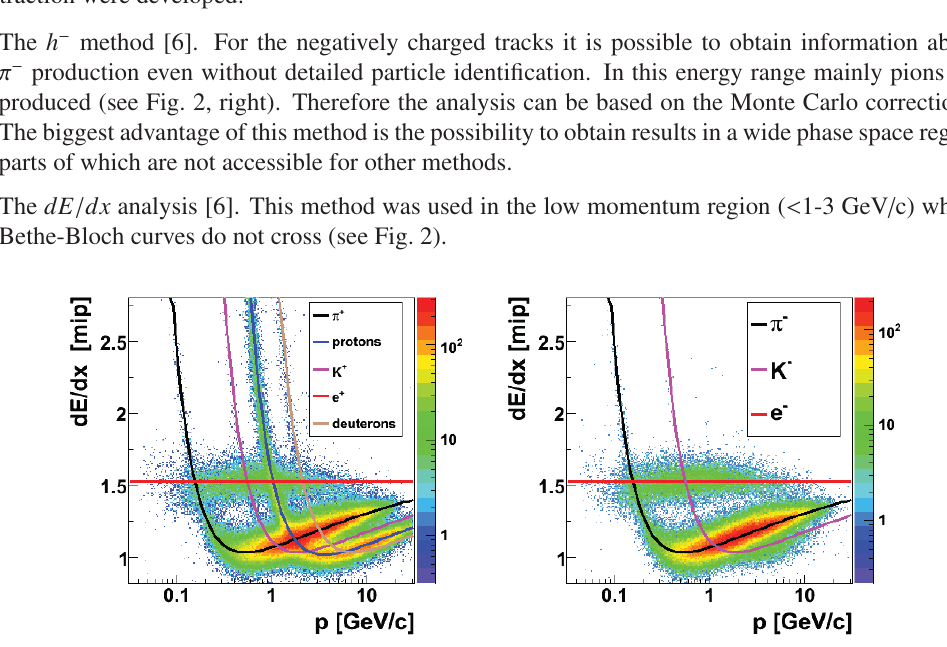
interacted with a thin 2 cm carbon target (0.04 λ I ) and a 90 cm T2K replica target (1.9 λ I ). This